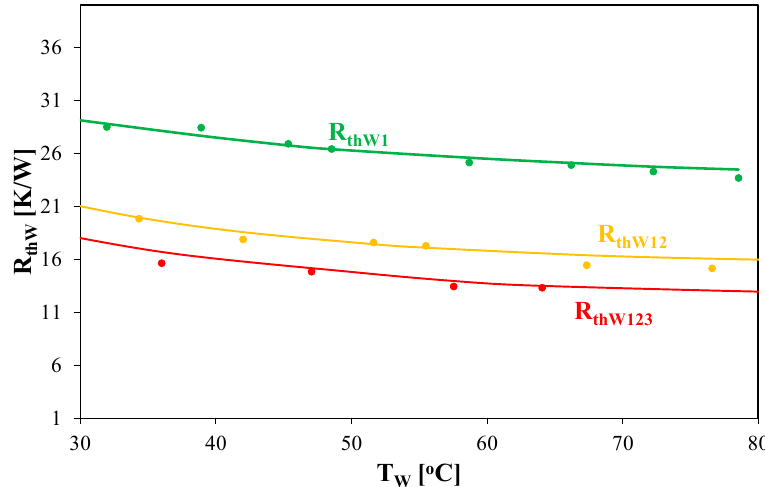
Figure 13. Dependence of thermal resistance of the inductor windings on the temperature of these windings T W1 with various number of powered windings at the same time.